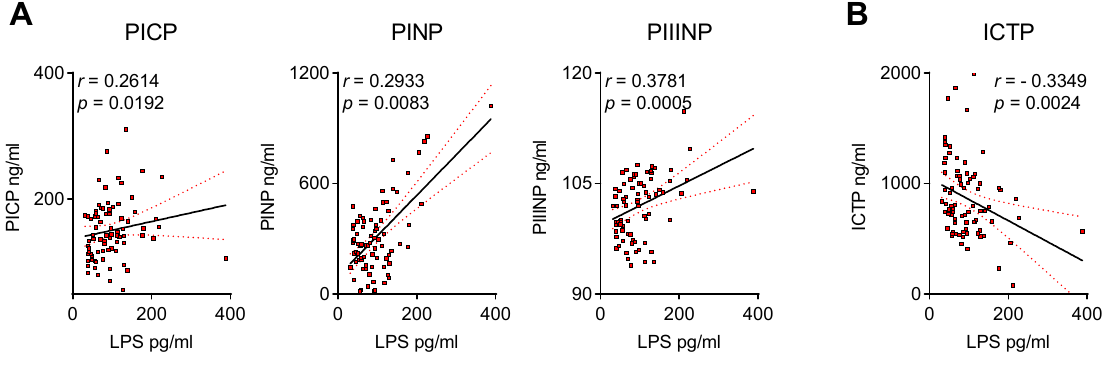
Figure 4. Circulating endotoxin associates with biomarkers of collagen turnover in patients with first-diagnosed AF. Elevated lipopolysaccharide (LPS) correlates with surrogate markers of collagen synthesis (procollagen I C-terminal propeptide, PICP; procollagen I N-terminal propeptide, PINP; procollagen III N-terminal propeptide, PIIINP) ( A ) and collagen degradation (C-telopeptide of type I collagen, ICTP) ( B ) in the plasma of early AF patients vs. controls. Results are expressed as single values ( n = 80), Spearman correlation coefficients and linear regression lines (black full lines) with 95% CI (red dotted lines).